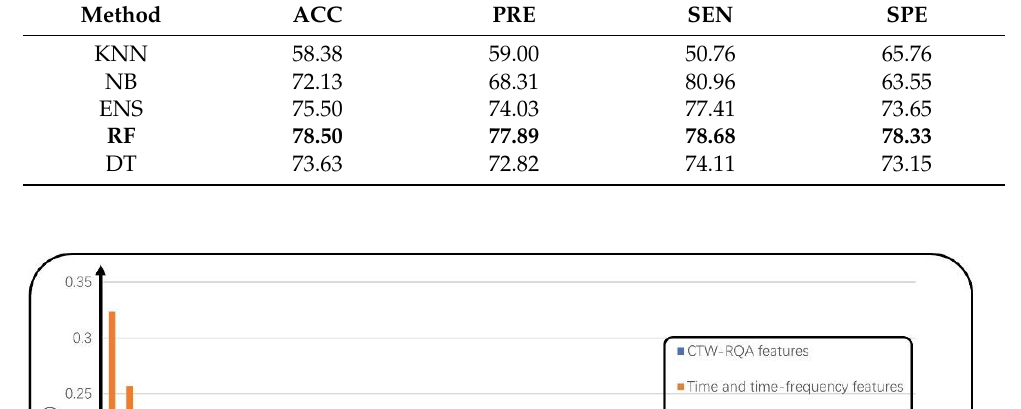
Table A2. AF detection performance based on CTW – RQA features ( n = 6).